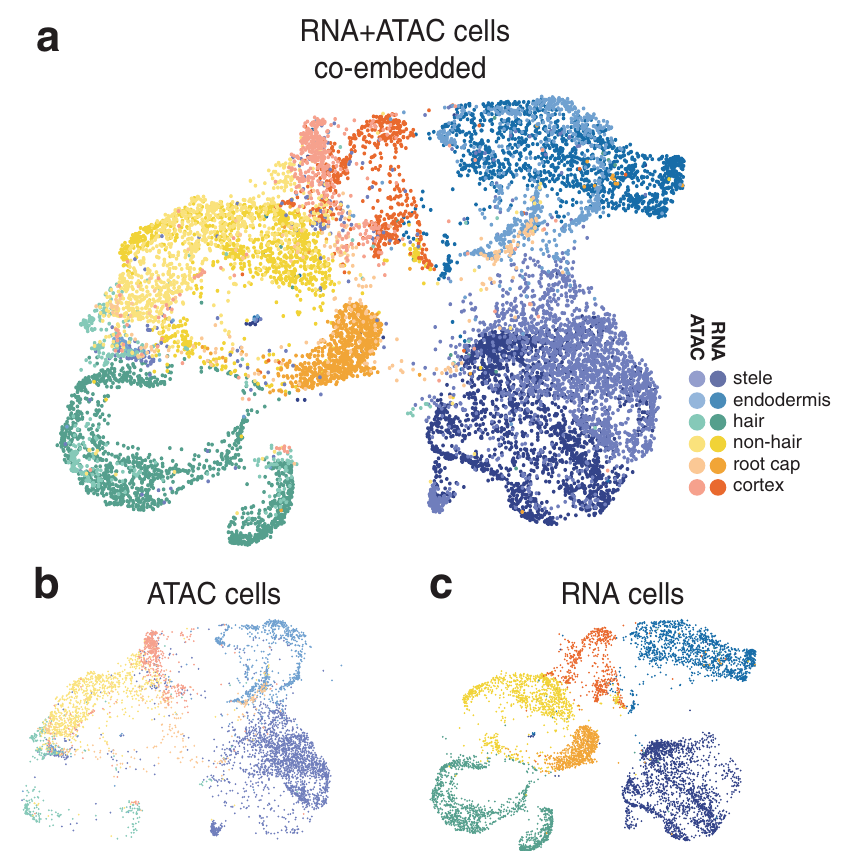
Fig. 2 scATAC-seq data can be integrated with scRNA-seq data to identify cell types. a UMAP co-embedding of root scATAC cells alongside root scRNA cells 5 . Cells are colored by broad tissue type, with scATAC cells colored in lighter shades and scRNA cells in darker shades. b UMAP from a , but showing only cells from the scATAC-seq experiment; c shows only cells from the scRNA-seq